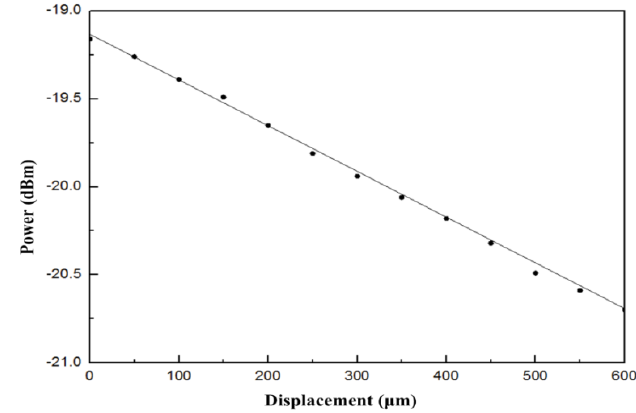
Figure 5. Changes in optical power as displacement increased at 50- μ m increments at an FBG temperature of 70